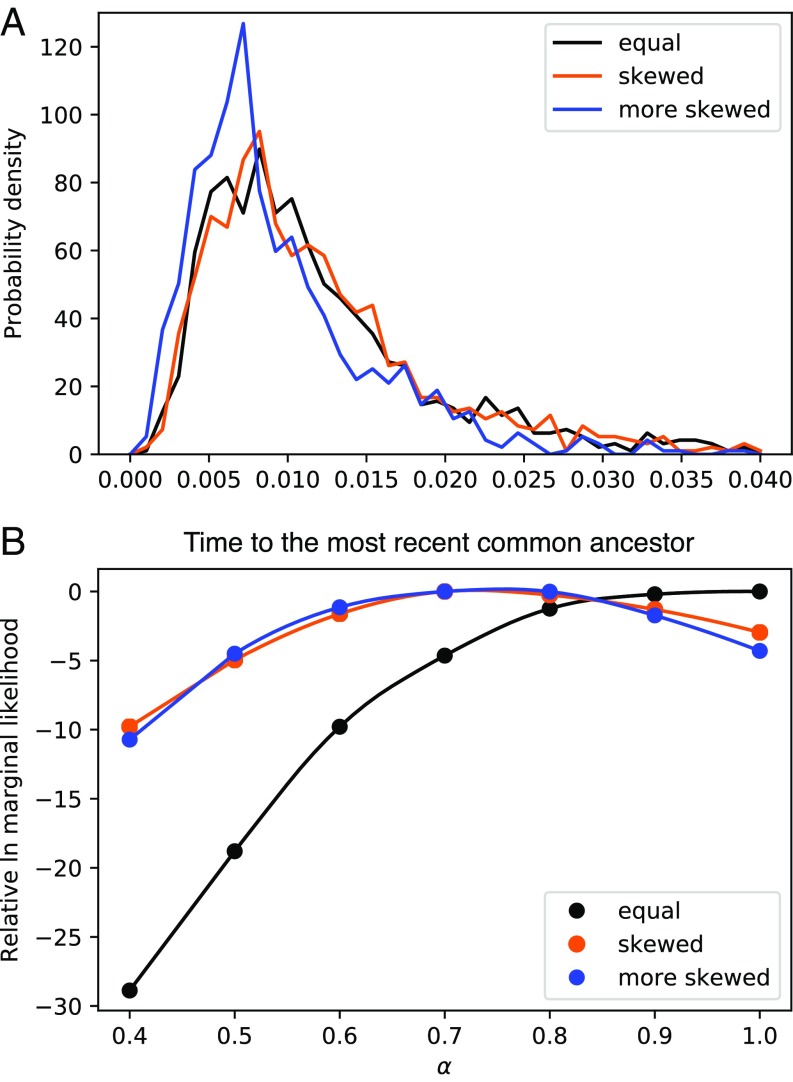
Comparison of the effect of variable environment on genealogy and estimation. (A) Effect on the time of the most recent common ancestor; histogram of 1,000 independent genealogies of 10 individuals. (B) Ln mL of a single-locus dataset for different values of α as a measure of the effect of the environment on the data.